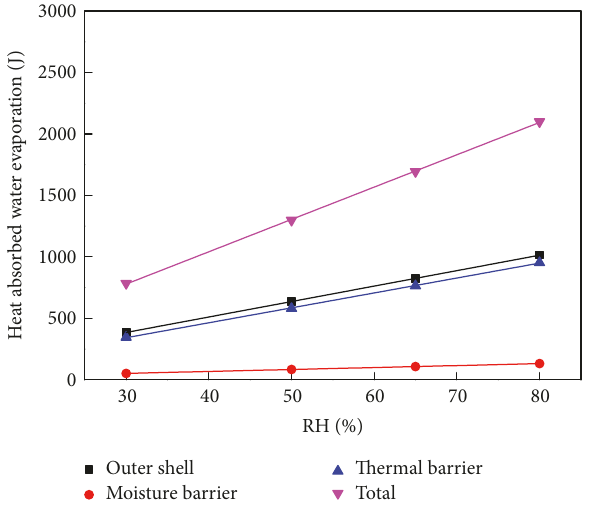
Figure 13: Heat absorbed by water evaporation against RH, with fitting line.